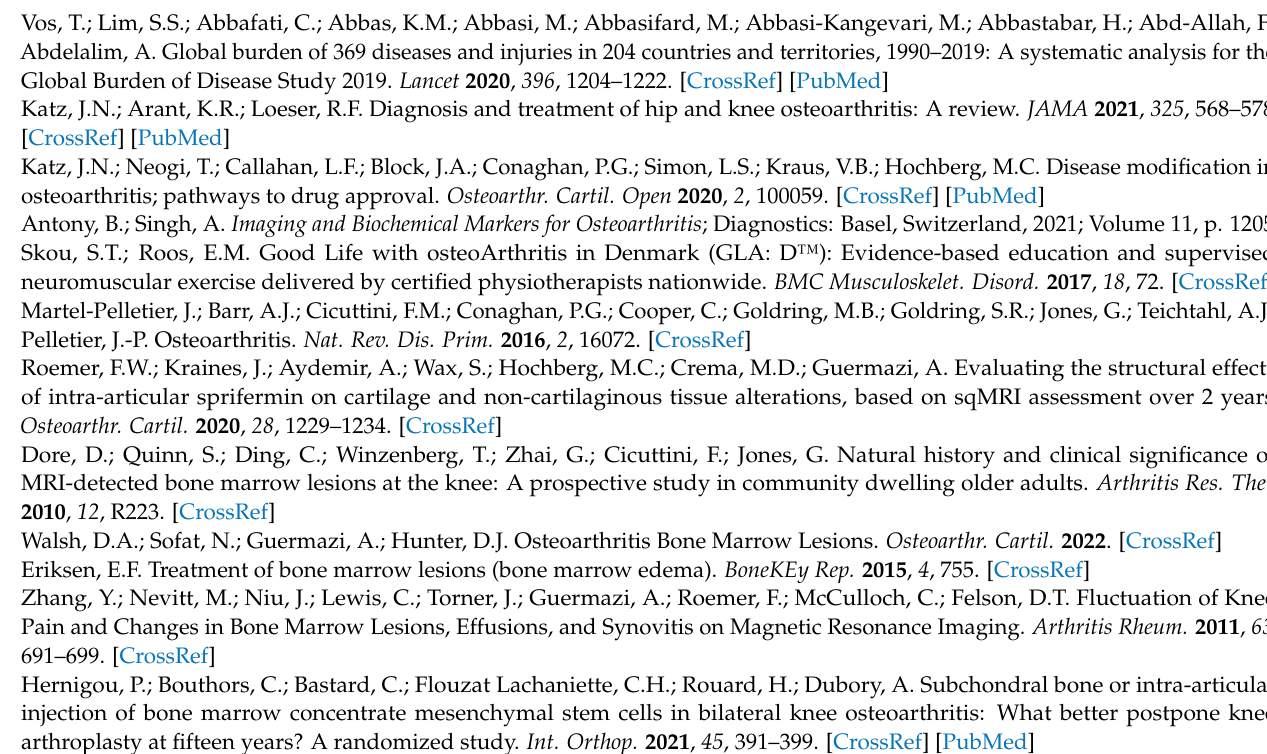
diagram. Table S1: Ovid Medline search strategy. Table S2: Search terms used for Clinicaltrial.gov and ANZCTR. Table S3: List of ongoing trials of intra-articular injectables for the treatment of knee OA. Table S4: OMERACT-OARSI response. Table S5: PRISMA 2020